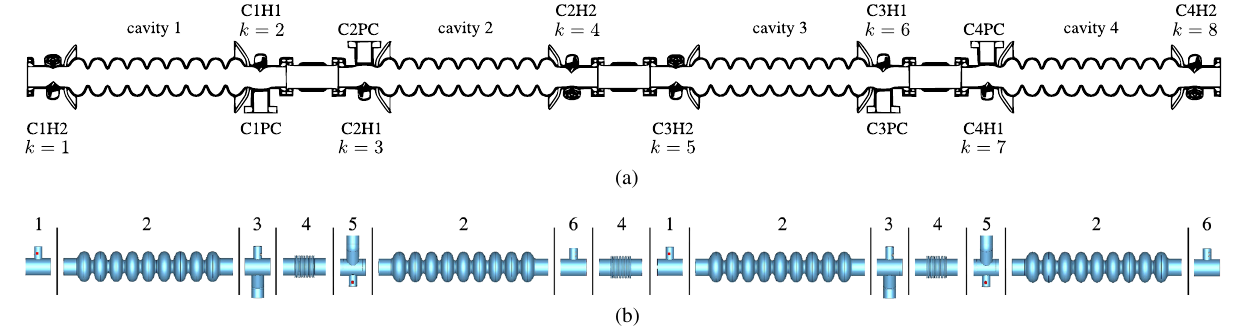
FIG. 2. (a) Arrangement of the four cavities in the module ACC39. The bellows are mounted in between the cavities. In the sketch C p H q indexes the HOM port q of the cavity p and C p PC the power coupler of the cavity p . Additionally, eight HOM couplers of the module are indexed by k . The picture was courtesy of Elmar Vogel [20]. (b) Decomposition of the ACC39 cavity string into individual CSC segments, which are modeled with CST MICROWAVE STUDIO® based on technical drawings. The indices of the scattering objects refer to Table II. The vertical black lines in between the objects indicate CSC segments whose scattering matrices are known analytically (circular waveguides with constant cross section and rotation objects). Note that additional bendings are attached to the power couplers (see objects with the indices 3 and 5) because waveguide ports have to be located on the boundary of the computational domain while using the Resonant Fast S-Parameter Solver in combination with the hexahedral grid in CST MICROWAVE STUDIO®.